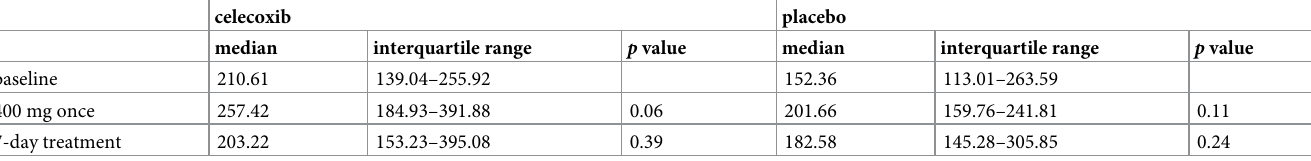
Table 1. Total electroencephalography power spectral density (absolute value).